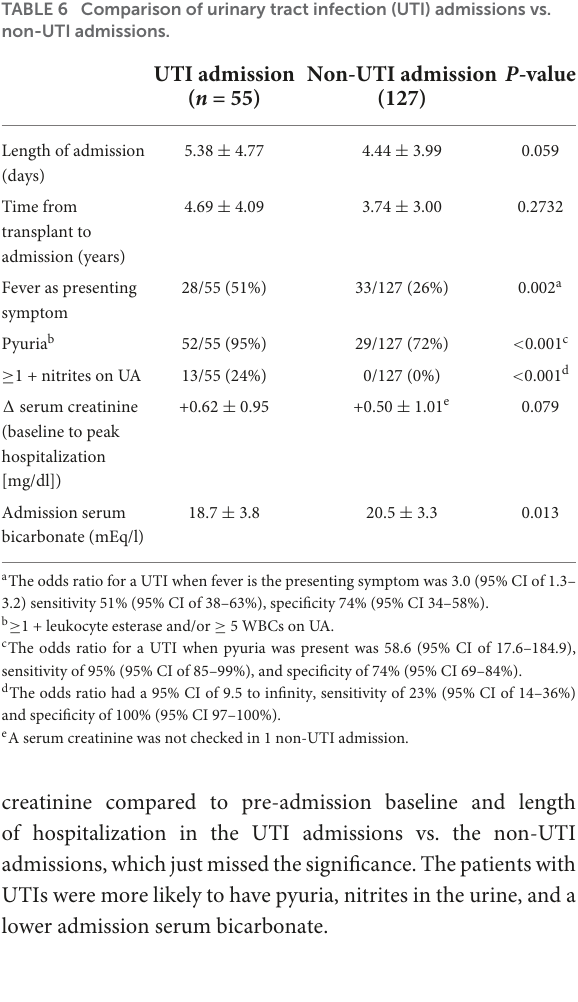
TABLE 7 Urine culture